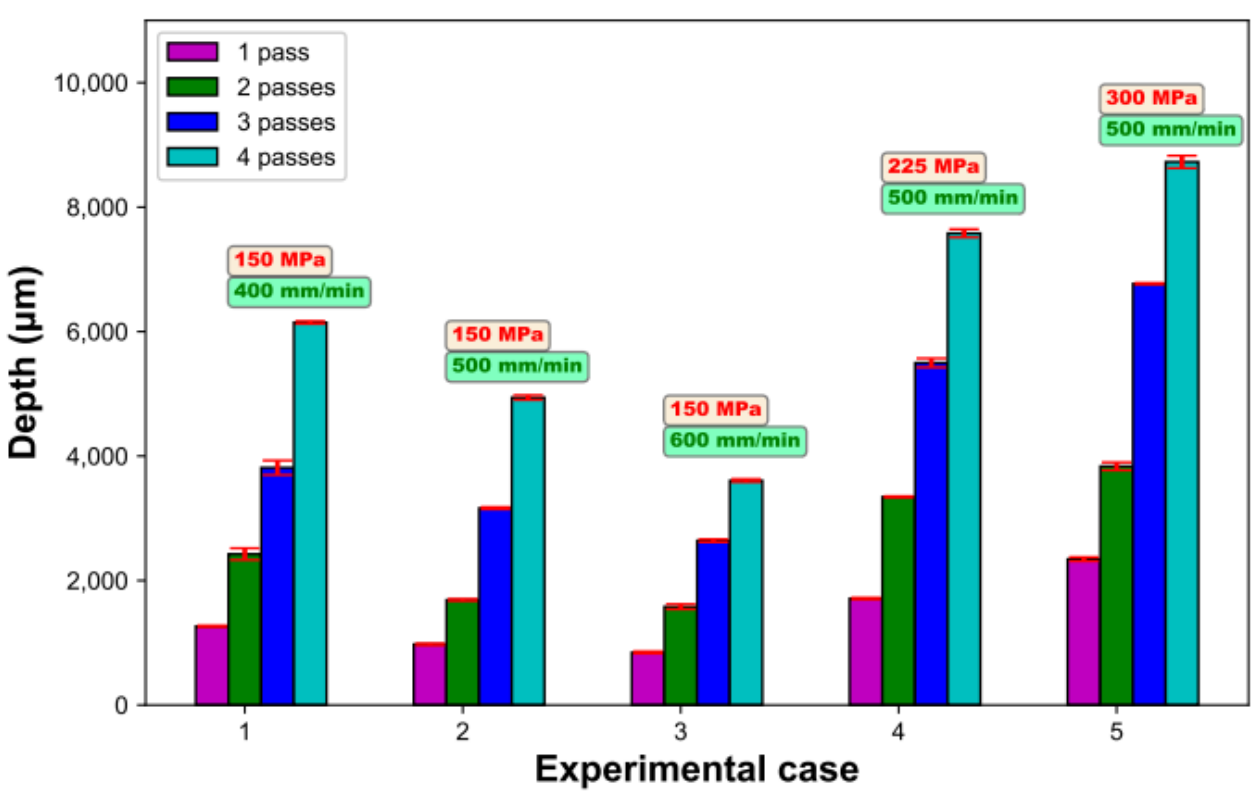
Figure 3. Influence of multipass strategy on the depth of penetration.